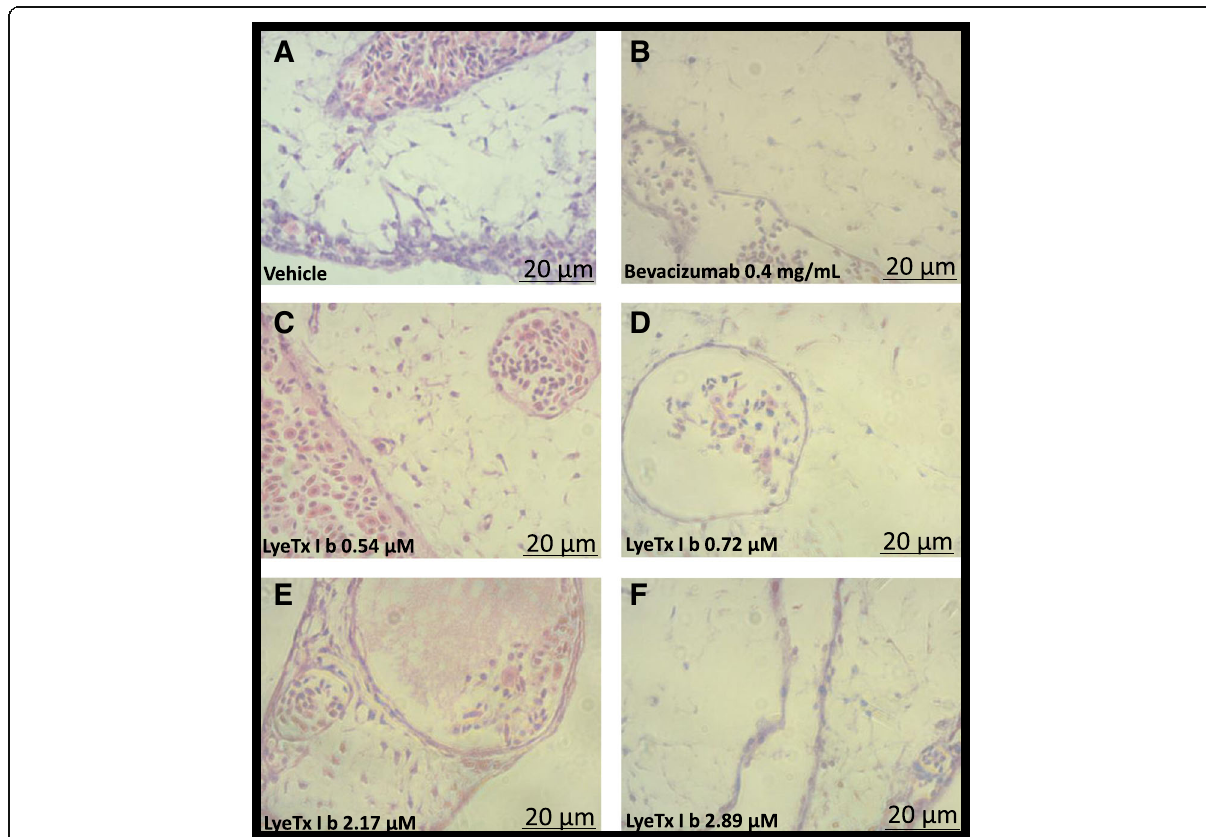
Fig. 11 LyeTx I b prevents neovascularization keeping the morphology integrity of CAM: A: Histological images illustrating CAM mesoderm after exposure to ( a ) Vehicle, ( b ) Bevacizumab 0.5 mg/mL, ( c ) LyeTx I b 0.54 μ M, ( d ) LyeTx I b 0.72 μ M, ( e ) LyeTx I b 2.17 μ M and ( f ) LyeTx I b 2.89 μ M over a 72-h period. ( a and c ) Vasculogenic reaction: simultaneous and co-localized vasculogenesis and hematopoiesis is observed. b , d , e and f show reduction in vasculogenesis and